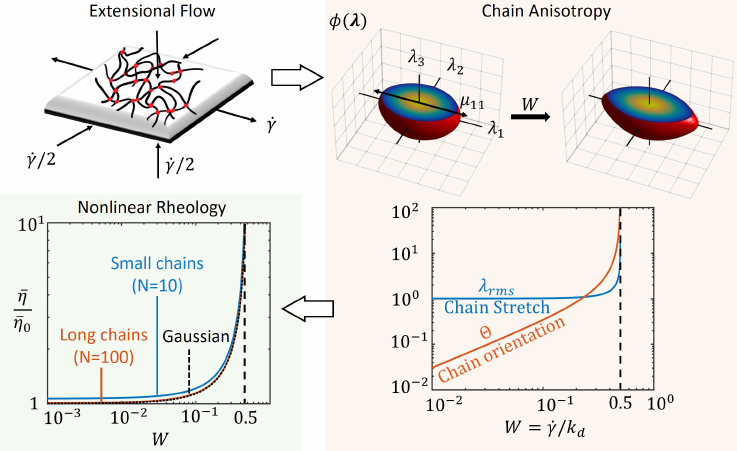
Figure 2. Steady extensional flow of a transient polymer network shown leading to chain anisotropy at steady state as seen from chain distribution function, φ ( r ) for different values of the Weissenberg number, W . The average chain stretch, λ rmd , and orientation, Θ , are obtained from the chain distribution tensor, µ as a function of W . The nonlinear rheology is then captured by the plot of non-dimensional viscosity ¯ η / ¯ η 0 , where ¯ η 0 = 3 ck B T / k d is the viscosity of the network at zero extension